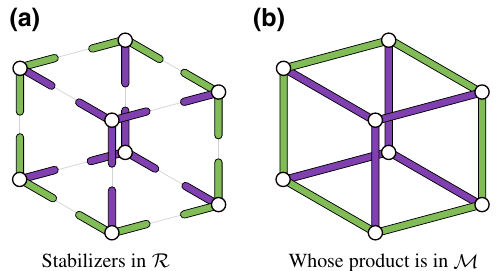
FIG. 10. A surviving stabilizer in the intersection R ∩ M . On the left are stabilizers of the six-ring resource states arrayed on each vertex of a lattice cell. These are of the form ZXZ (green- purple-green) or XXX (purple-purple-purple). The product can be rewritten in terms of XX (purple) and ZZ (green) and is therefore also in the measurement group. This type of surviving stabilizer is a check operator of the FBQC instrument network.